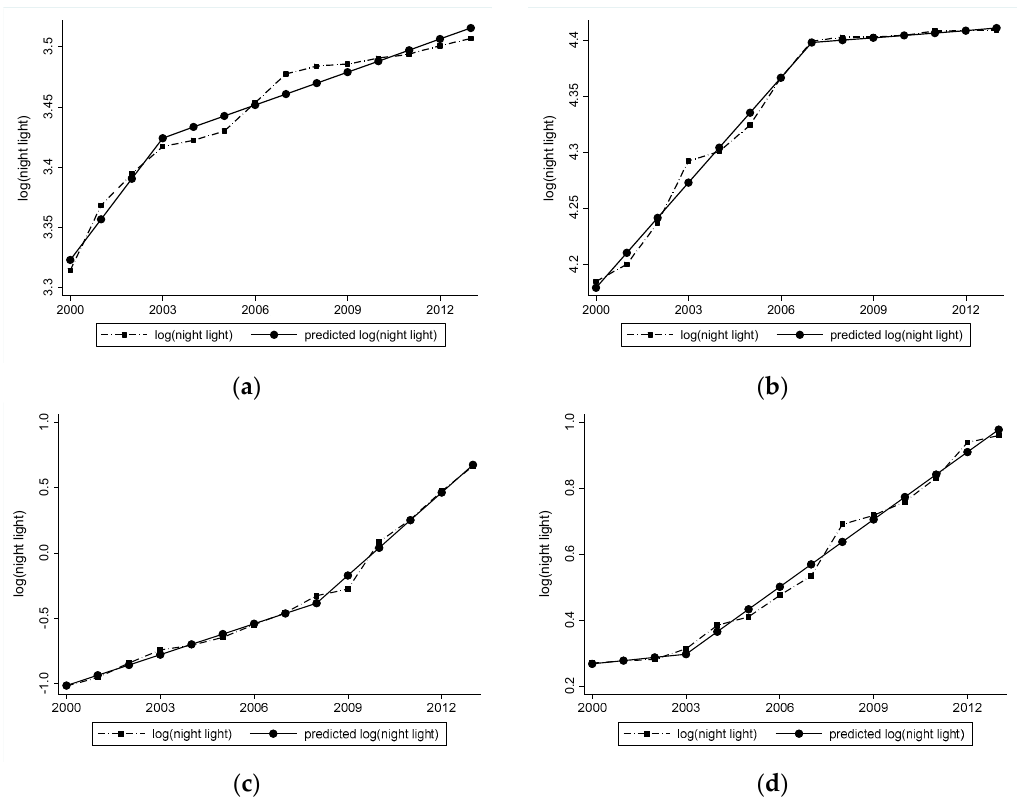
Figure 1. Estimating city-level structural breaks in nighttime light. ( a ) Beijing; ( b ) Shanghai; ( c ) Dingxi; ( d ) Jinchang.